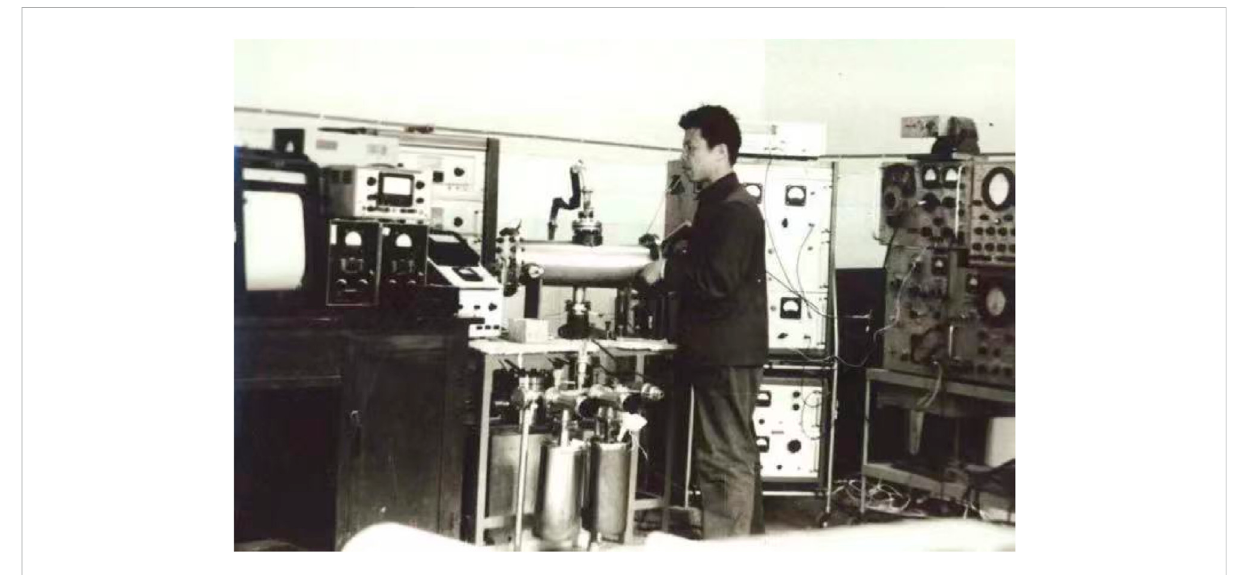
FIGURE 2 Prof. Wang Yiqiu worked on a cesium tube atomic clock prototype in